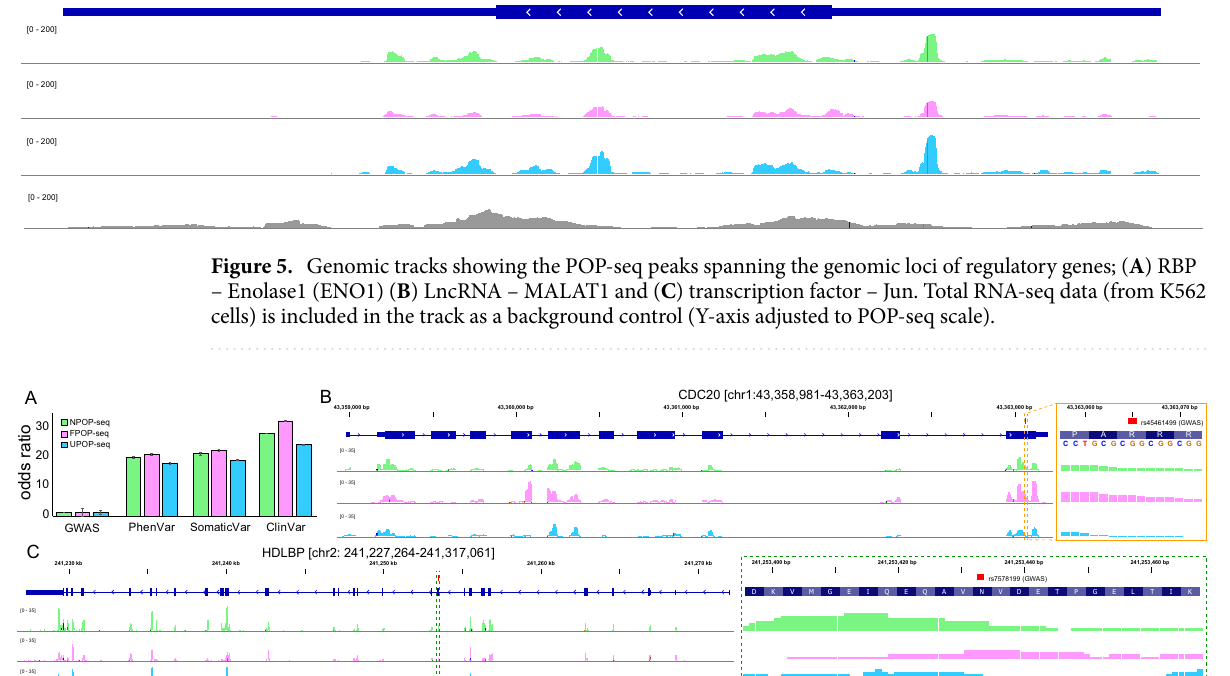
cally interact with RBPs in pathological conditions. In general, highly expressed RNAs are expected to be more available for binding by proteins and therefore exhibit higher RNA binding events. Therefore, we tested the association between the expression levels (high and low) with the number of POP-seq peaks per unit length for both lncRNA and non-lncRNA genes across the technical replicates. We found that the replicates exhibited a reproducibility in the trend (Figure S4A), irrespective of the POP-seq protocols. To test whether such a trend can